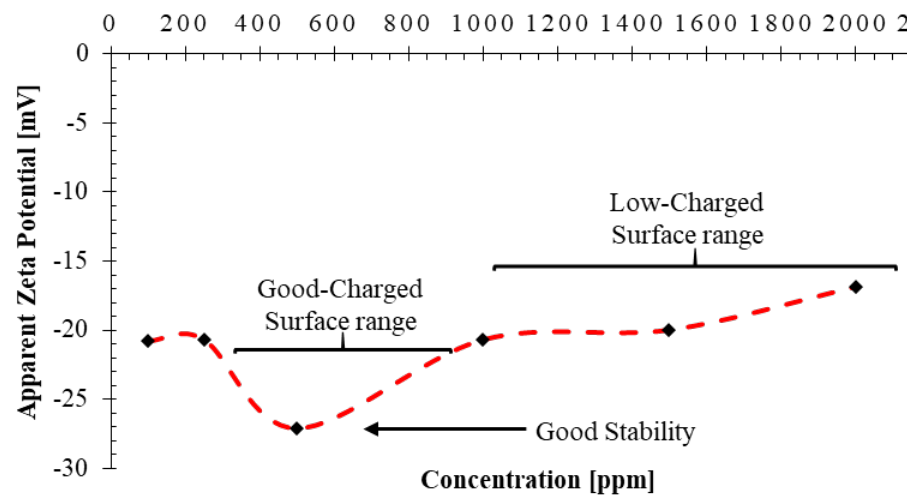
Figure 12. Zeta potential measured for the prepared nanofluids. The measured zeta potential peaks at NC concentration of 500 ppm.